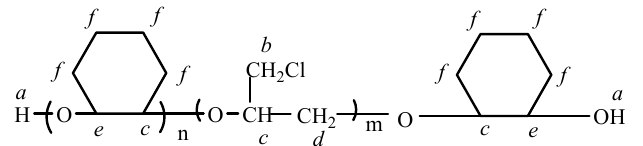
Figure 4. Structure analysis.